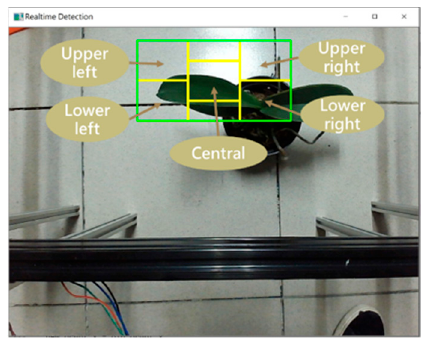
Figure 29. Five sections in the triggering area of the camera.